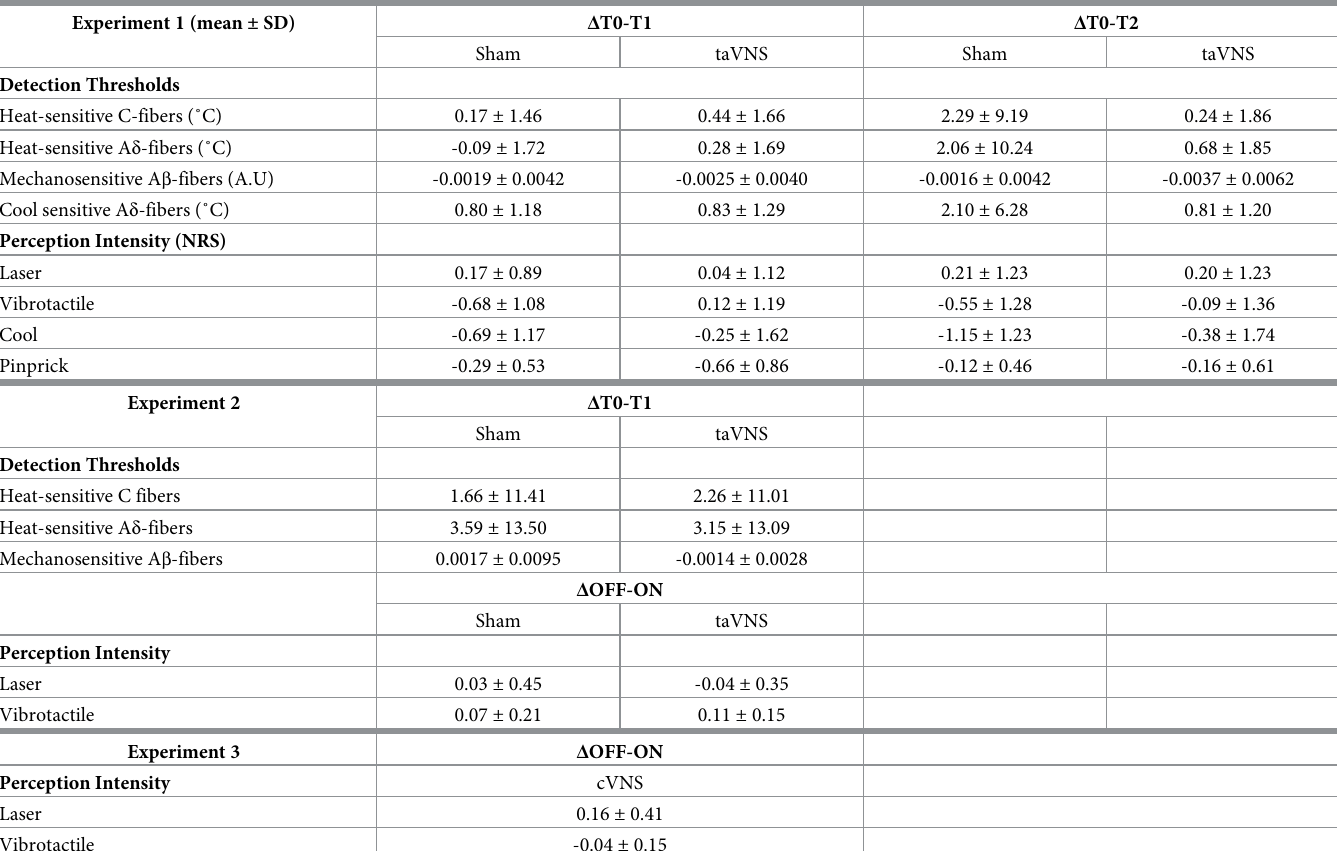
Table 4. Changes in detection thresholds and perception intensity (Experiment